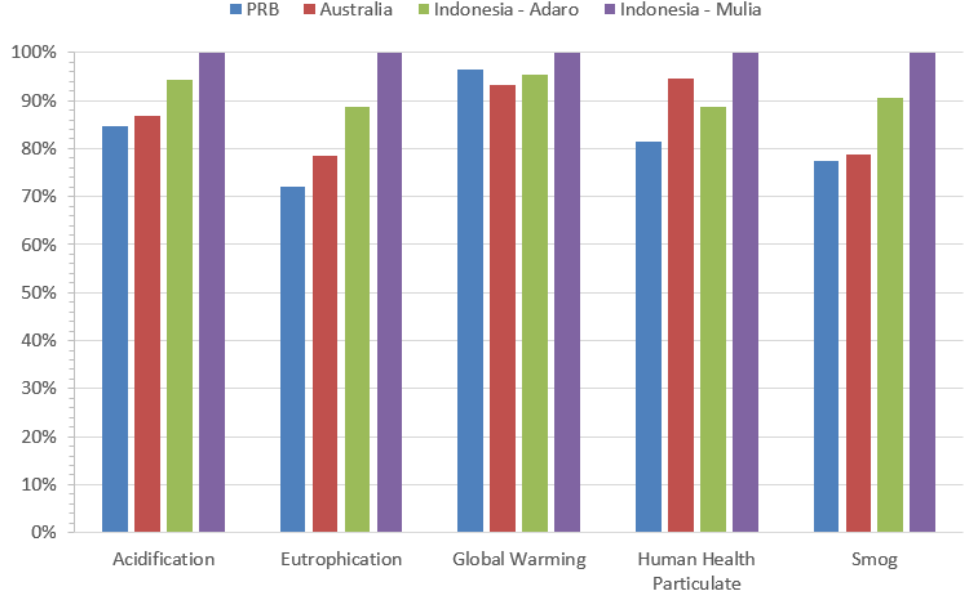
Figure 5. TRACI 2.1 impact assessment results for the Japan scenario with ocean transport impacts removed. Results are normalized to highest contribution in each impact category. Global warming values taken from previous section.